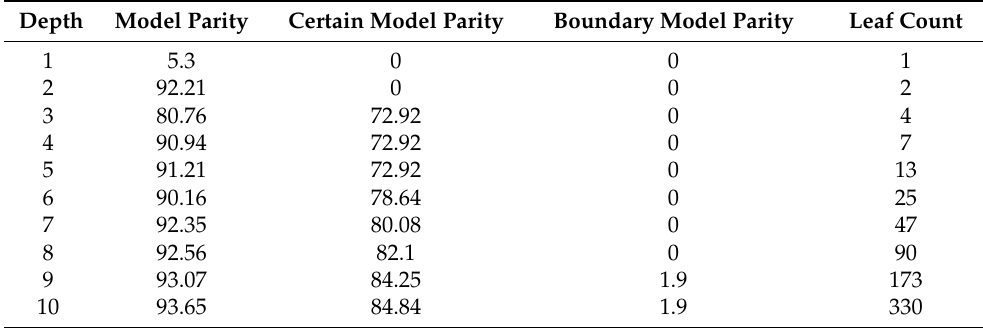
Table 7. Evaluation of the interpretable models for the US Adult Census dataset generated by TRE-PAN at depths ranging from 1 to